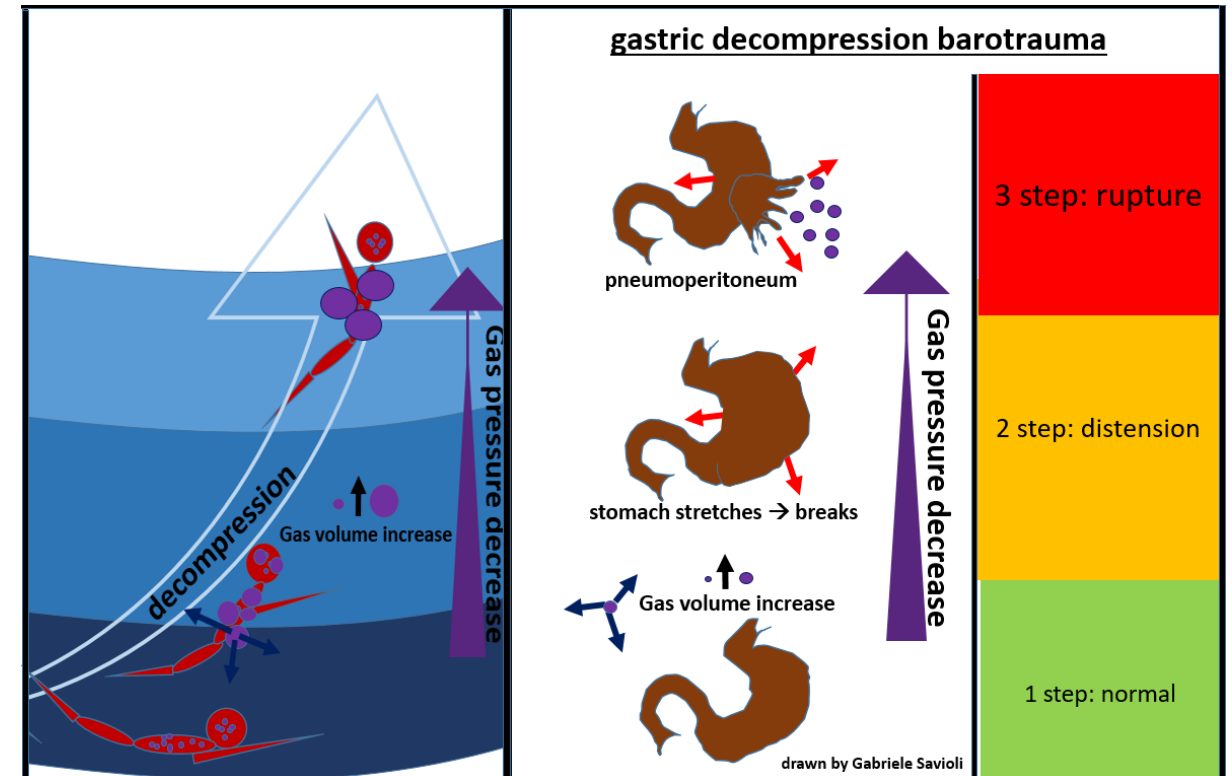
Figure 8. gastric decompression barotrauma.